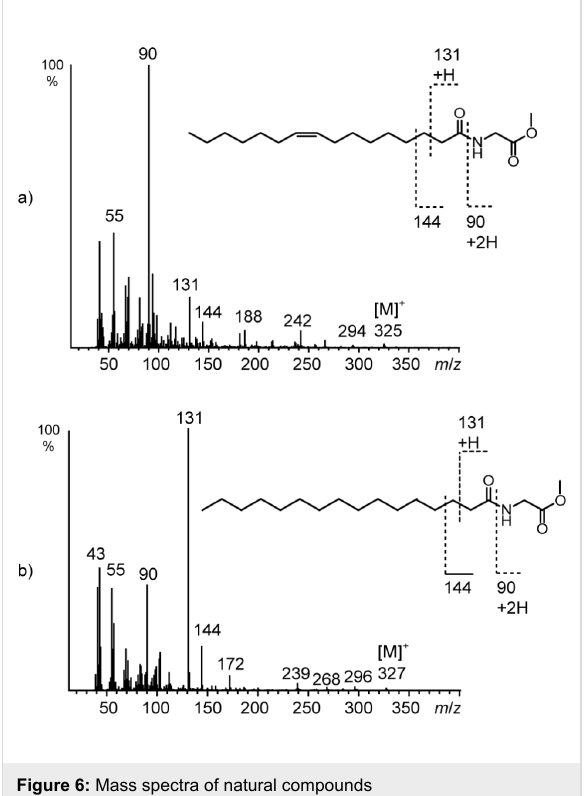
Figure 6: Mass spectra of natural compounds a) R ( 11 , C16:1-NAGME) and b) S ( 10 , C16:0-NAGME).